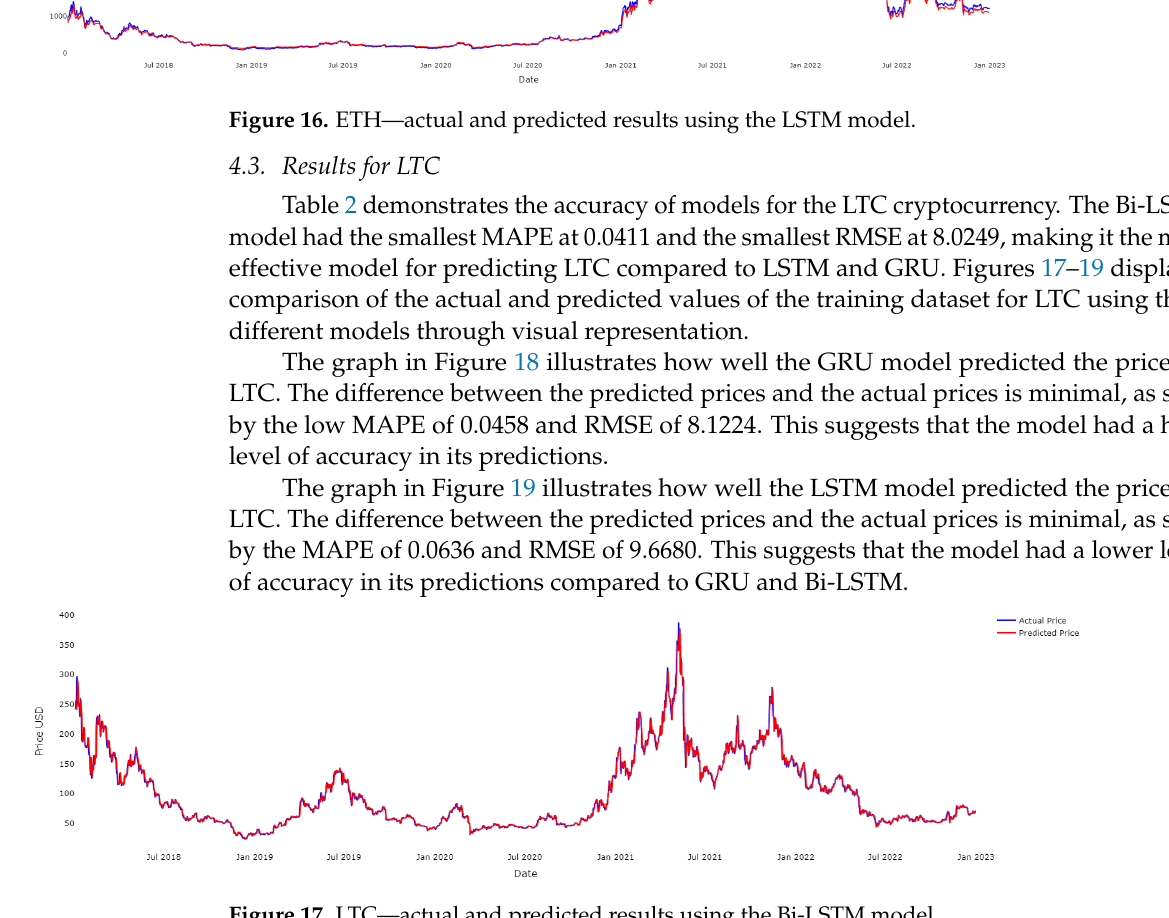
Figure 17. LTC—actual and predicted results using the Bi-LSTM